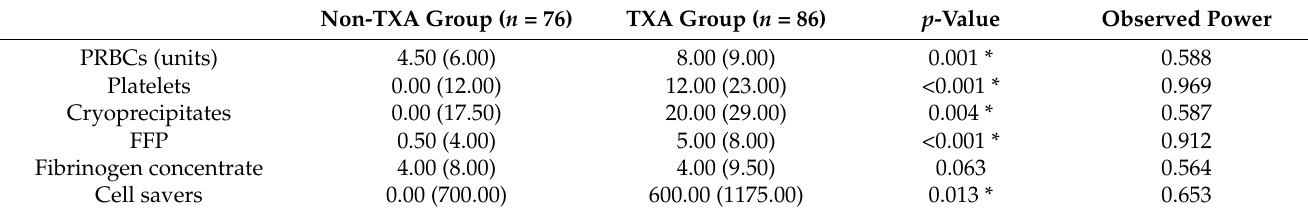
Table 2. Intraoperative transfusion requirements of blood components categorised by intraoperative treatment of TXA.